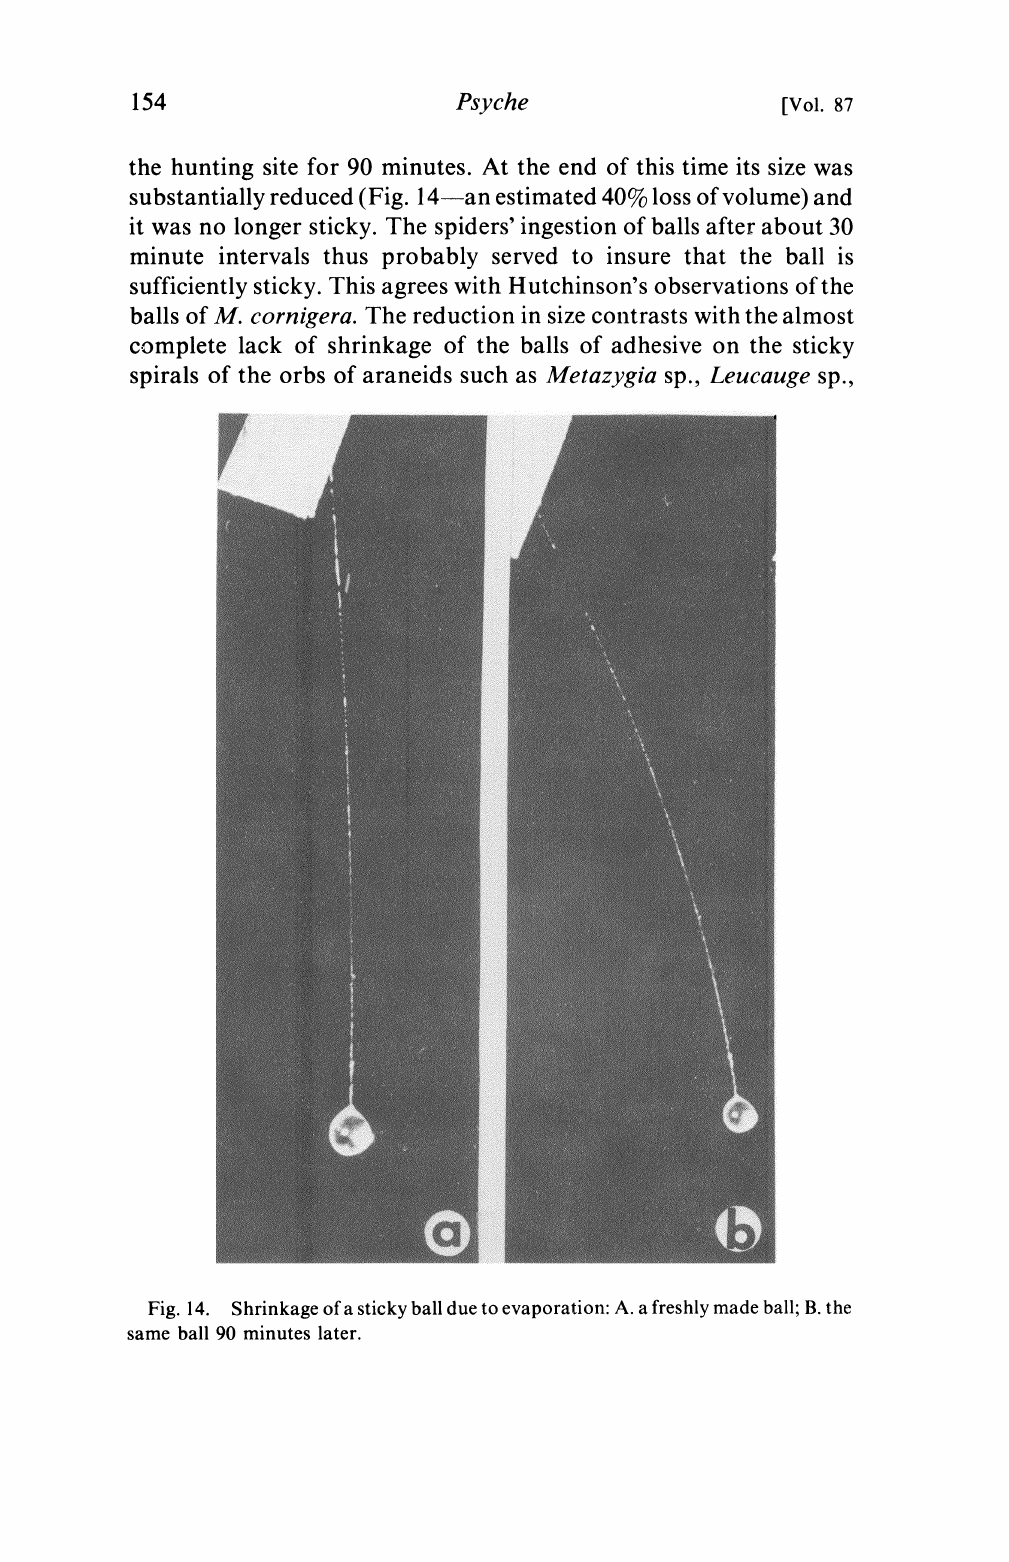
Fig. 14. Shrinkage of a sticky ball due to evaporation: A. a freshly made ball; B. the same ball 90 minutes